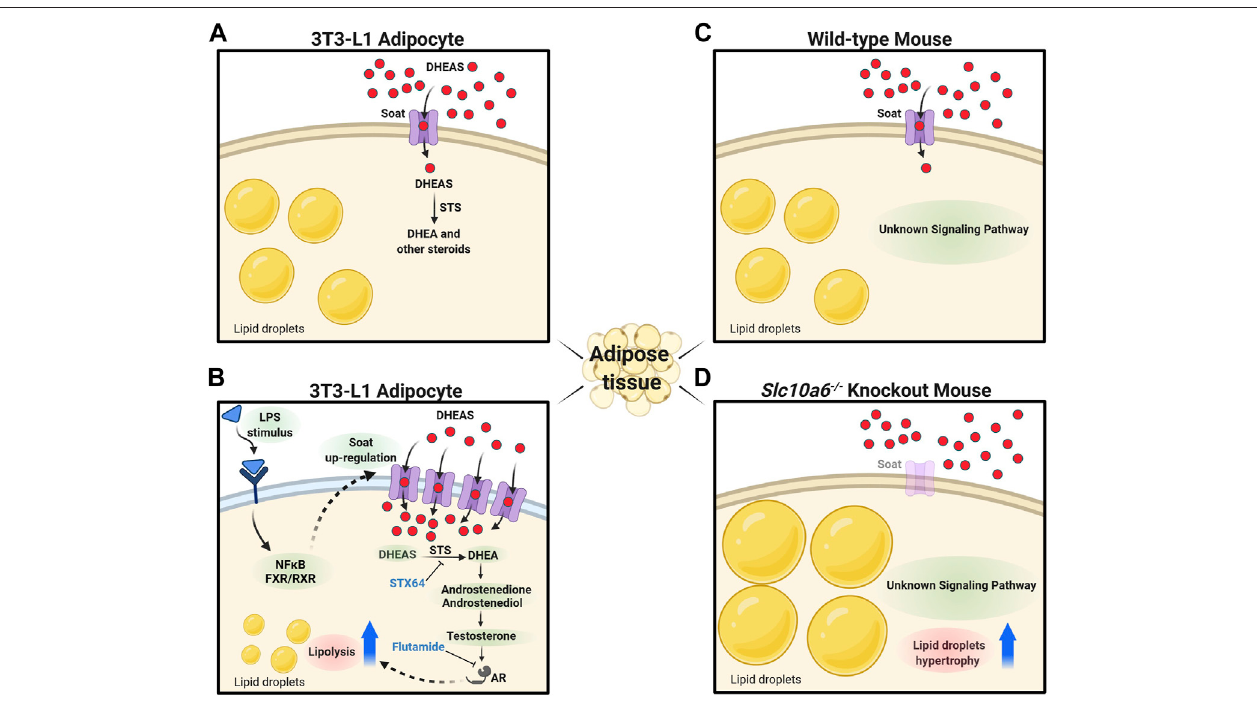
FIGURE6| Proposed role ofSoat inlipid dropletformation and steroid-triggered lipolysis. (A) Soat expression in theplasma membraneof3T3-L1adipocytes and uptake of DHEAS under physiological conditions. (B) Upregulation of Soat expression by LPS treatment through JNK and NF- κ B – dependent pathways increases DHEAS uptake and stimulation of lipolysis via an AR-dependent pathway. The lipolytic effect of DHEAS could be blocked by STX64 and fl utamide. (C) As DHEAS levels are lowin mice, Soat may mediateuptake ofother relevant sulfated steroids here. (D) Absence ofsteroidsulfate uptake through Soat in Slc10a6 − / − knockout mice could lead to the hypertrophy of lipid droplets in adipocytes via hitherto unknown signaling pathways. DHEAS, dehydroepiandrosterone sulfate; DHEA, dehydroepiandrosterone; STS, steroid sulfatase; STX64, STS inhibitor; LPS, lipopolysaccharide; NF- κ B, nuclear factor “ kappa-light-chain-enhancer ” of activated B-cells; FXR, farnesoid X receptor; RXR, retinoid X receptor; AR, androgen receptor; fl utamide, androgen receptor antagonist. The fi gure was created with biorender.com.